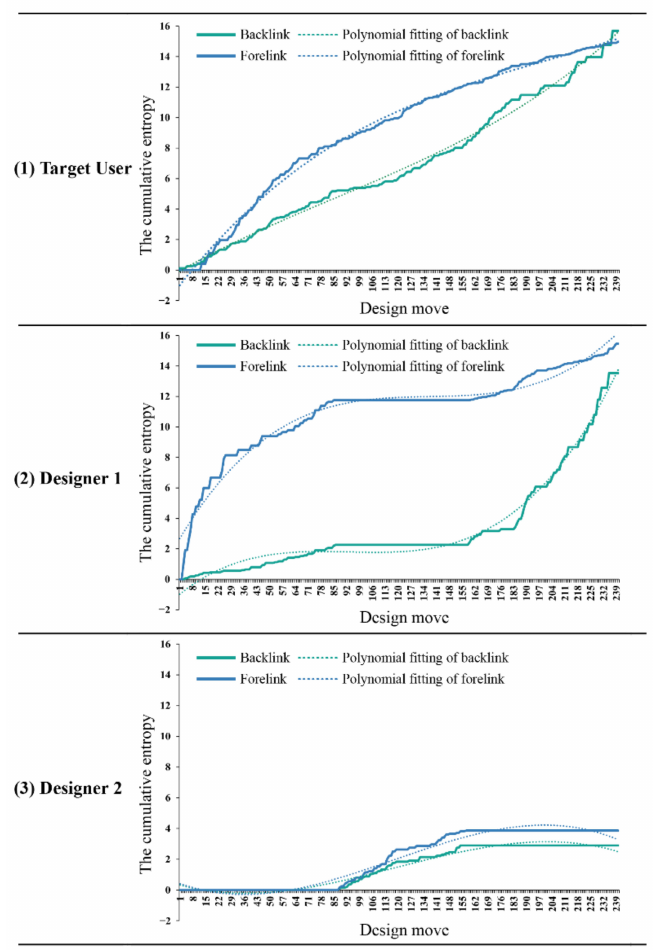
Figure 6. The cumulative entropies of forelinks and backlinks of each